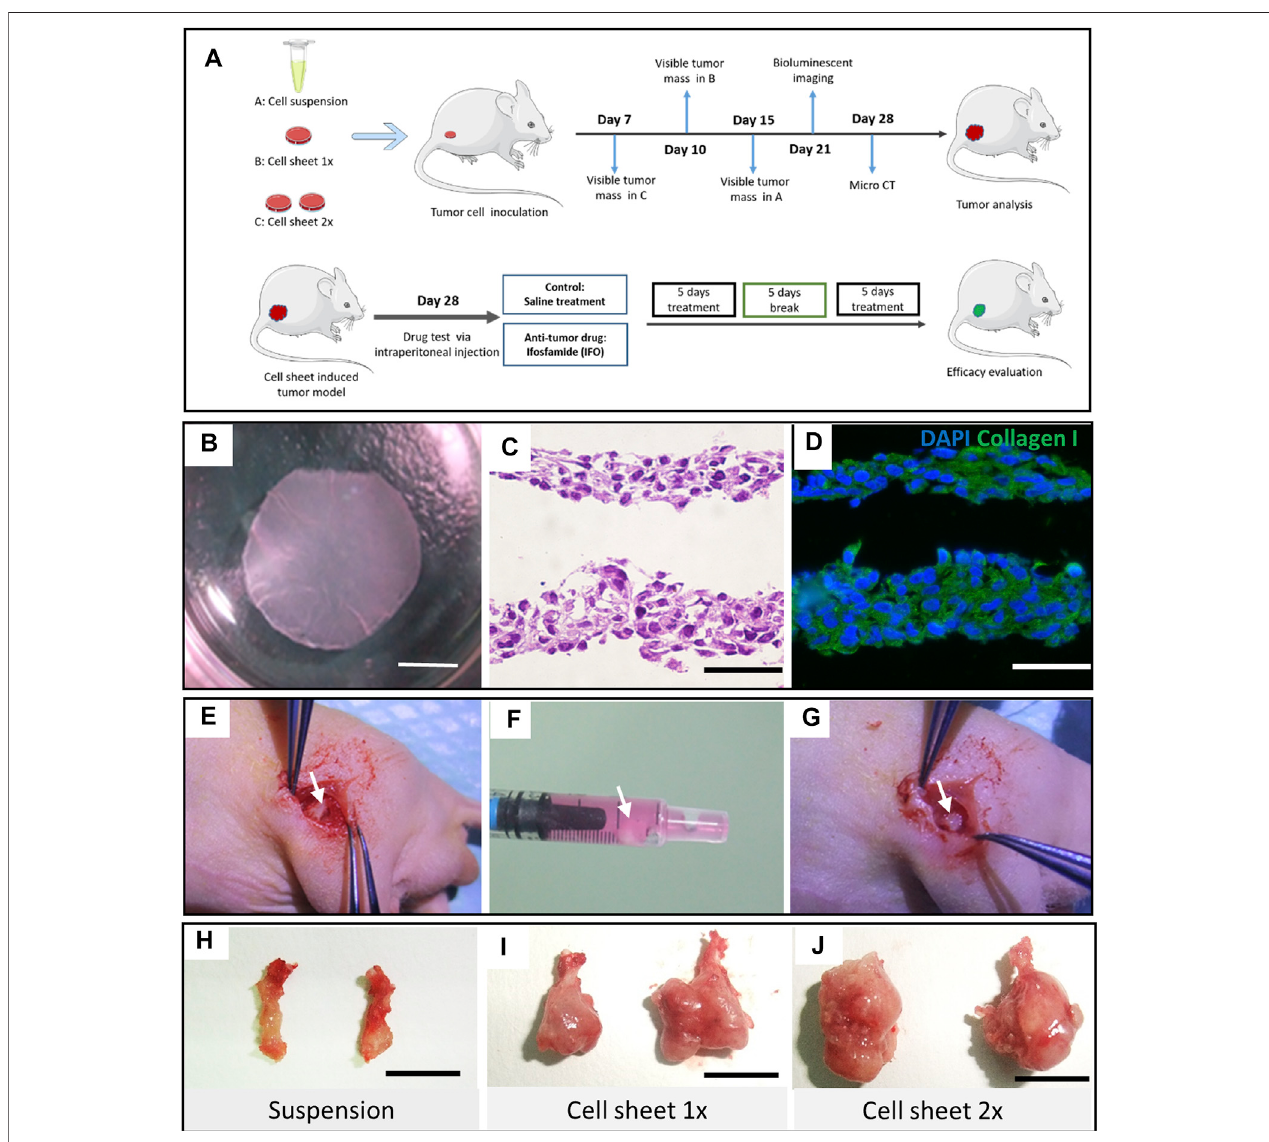
FIGURE 1 | Study design and OS cell sheet characterization and implantation. (A) Schematic graph of the study design. Cell suspension, one piece of cell sheet and twopiecesofcellsheetweretransplanted intothedistalfemur ofnudemice,respectively. (B) IntactLuc-143b OScellsheet detachedfromaUP-cell12-wellculture well. Scar bar (cid:2) 4 mm. (C) Hematoxylin and eosin staining of the cell sheet. Scar bar (cid:2) 50 μ m. (D) Immuno fl uorescence staining of collagen type I (green) and nuclear (blue) in the OS cell sheet. Scar bar (cid:2) 50 μ m. (E) An orthotropic distal femur defect was made. (F) OS cell sheet collected in the syringe. (G) OS cell sheet transplanted in site on the defect. Representative bone tumor lesion induced by cell suspension (H) , one piece of cell sheet (I) , and two pieces of cell sheet, (J) respectively, scale bar (cid:2) 1 cm.